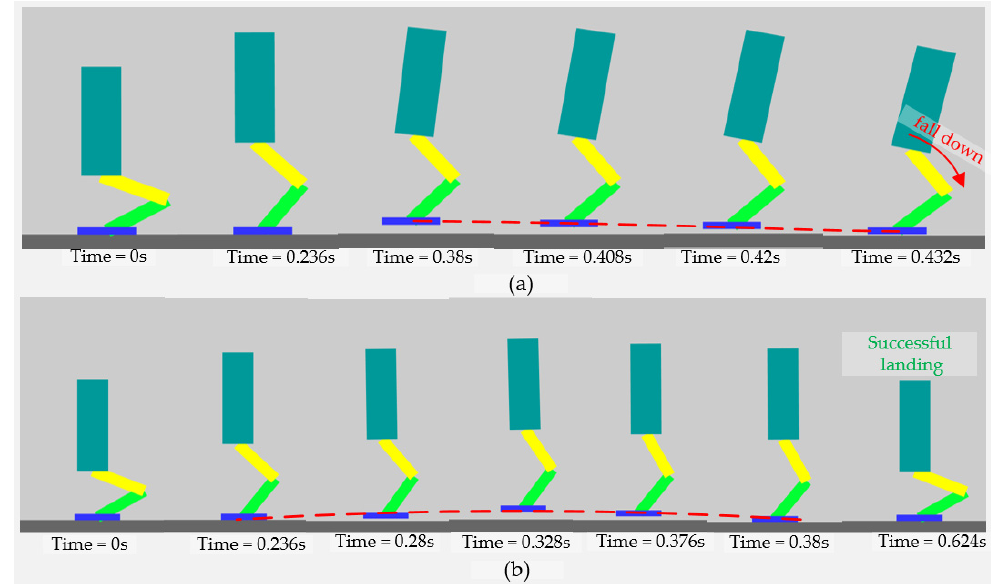
Figure 7. Demonstration of different jump cases with different controllers in the flight phase. ( a ) A failed jump and ( b ) a successful jump.